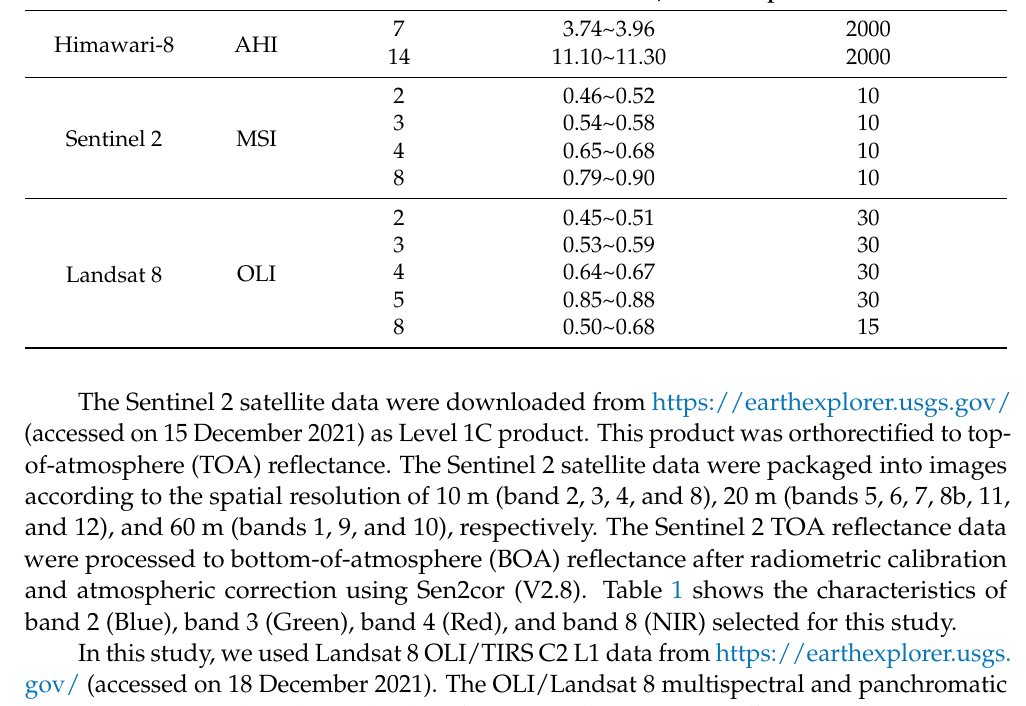
Table 1. Bands of Himawari-8 HLGD, Sentinel 2, and Landsat 8 imagery used in current study. Satellite Sensor Band Number Band Width ( µ